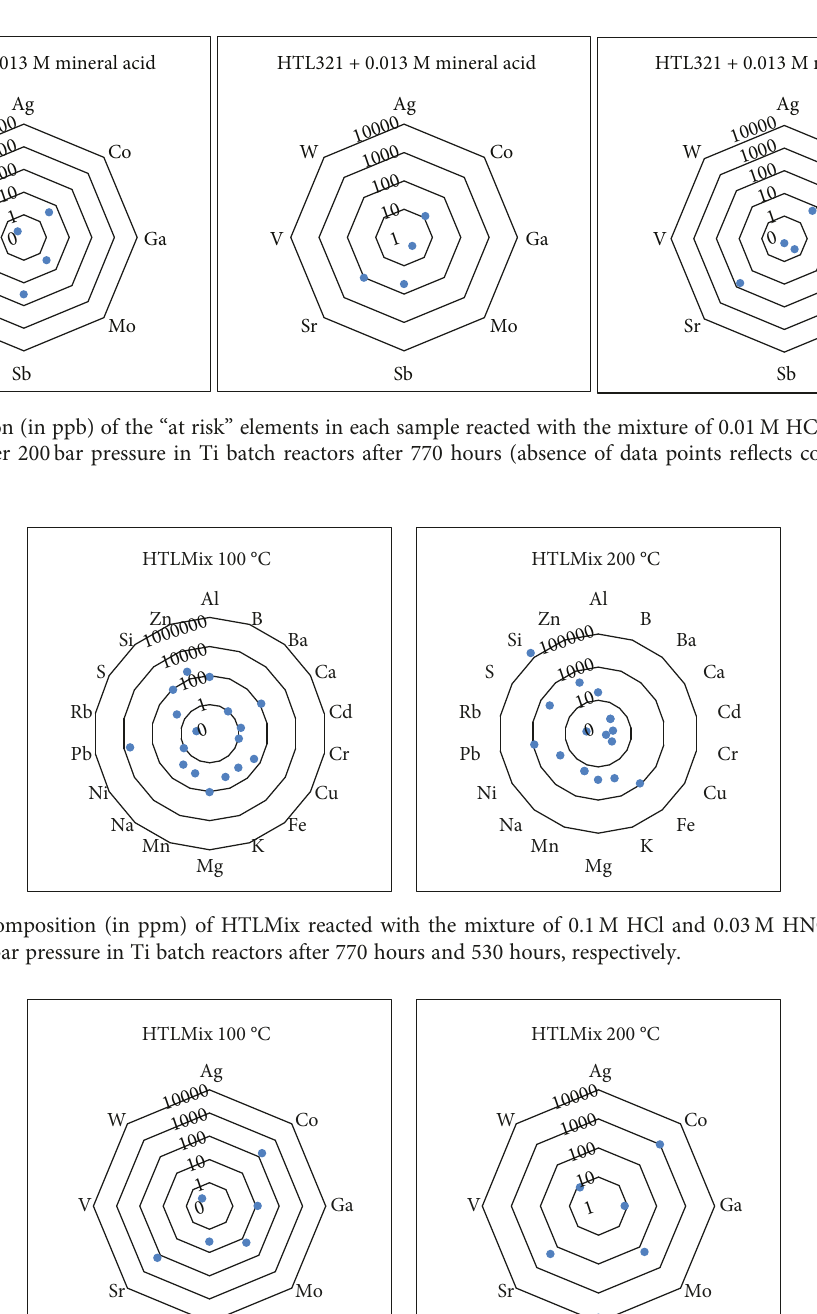
Figure 12: Concentration (in ppb) of the “ at risk ” elements in HTLMix reacted with the mixture of 0.1 M HCl and 0.03M HNO 3 at 100 ° C and 200 ° C temperature under 200bar pressure in Ti batch reactors after 770 hours and 530 hours, respectively (absence of data points re fl ects concentrations below the limits of